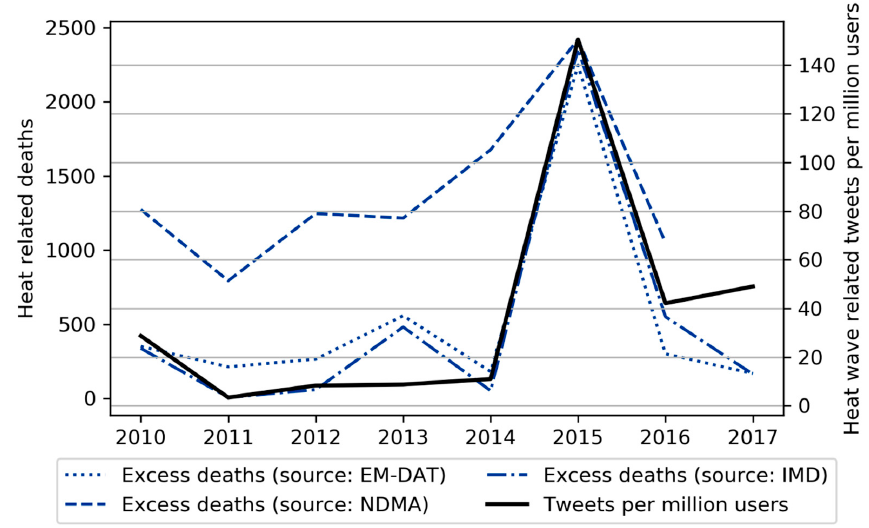
Figure 5. The annual number of heat wave related tweets per million users compared to three heat related mortality datasets. Table 4. Pearson correlation coefficient between mortality data according to the three available mortality databases and the Twitter and heat wave indicators, together with their significance (1 − p ). Pearson Correlation Coefficient Significance